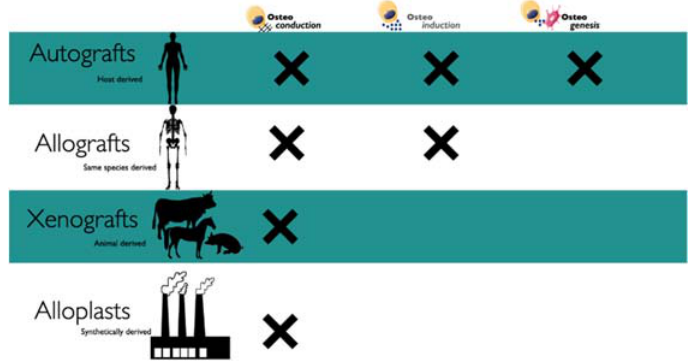
Figure 3. Characteristic of bone grafts according to the origin.